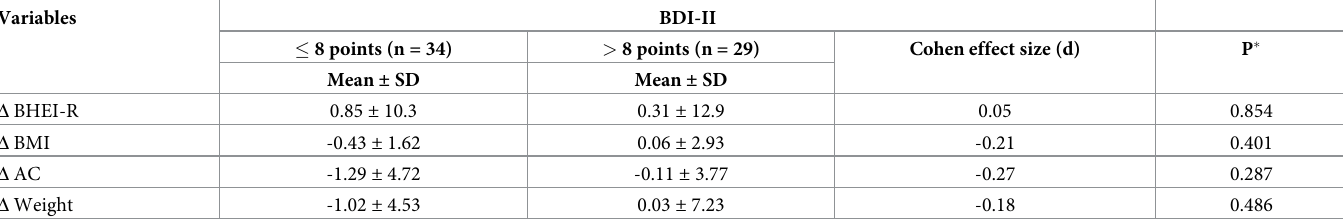
Table 10. Classification of BDI-II (dichotomized at the median) associated with the BHEI-R, BMI, AC and weight of patients with metabolic syndrome, Porto Ale- gre, Brazil (n = 63).